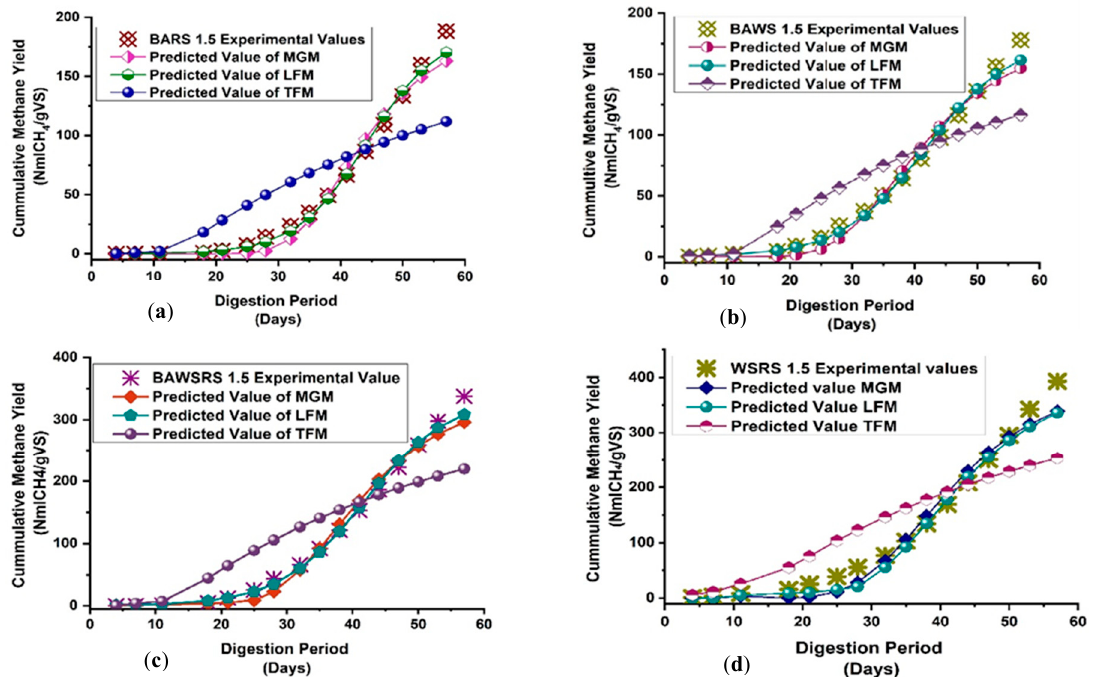
Figure 4. Cumulative Methane Production–Experimental; Transference, Logistic and Modified Gompertz Model for Reactors ( a ) Baggase and Rice straw(BARS), ( b ) Baggase and Wheat Straw (BAWS) ( c ) Baggase, Wheat straw and Rice starw (BAWSRS), ( d ) Wheat straw and Rice Straw (WSRS) with S/I 1.5.